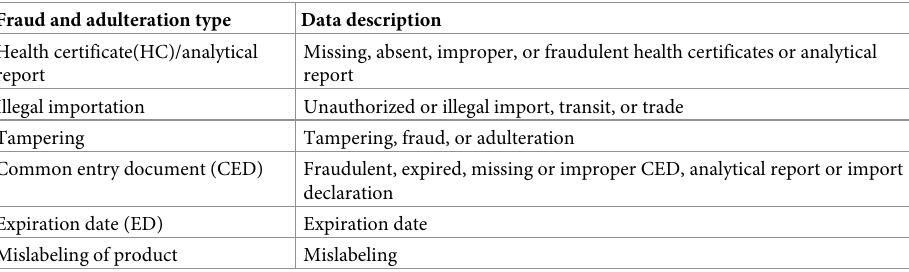
Table 1. Categories of FFA notifications in RASFF